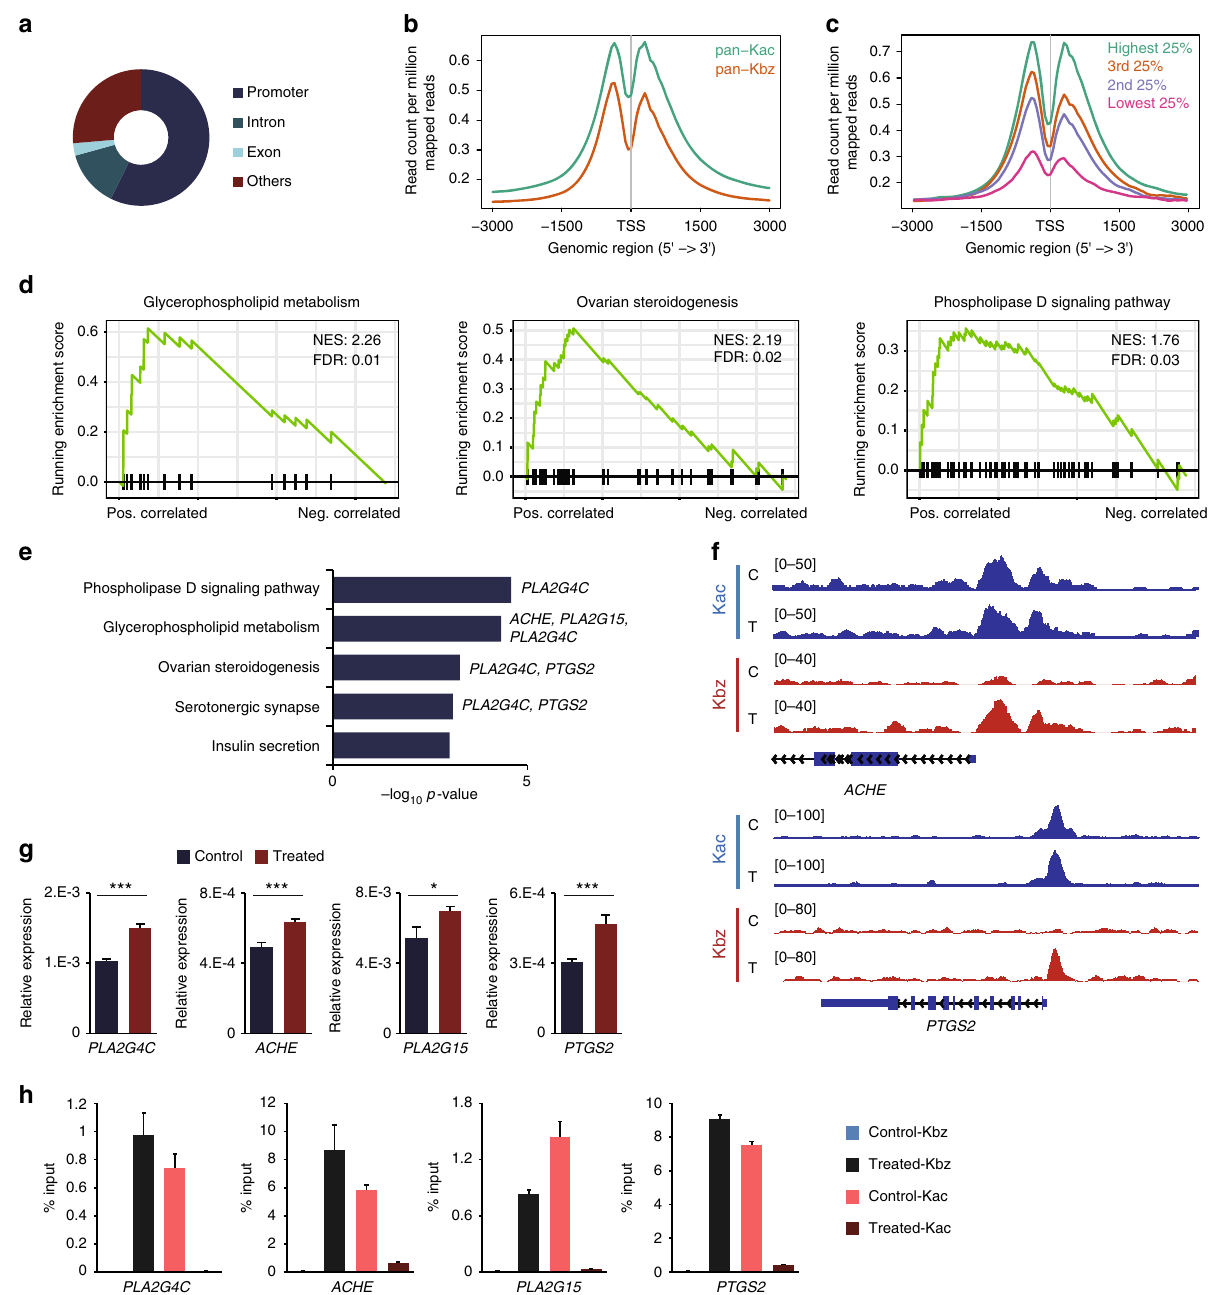
Fig. 6 Genome-wide localization and physiological relevance of histone K bz in HepG2 cells. a Genome-wide distribution of histone K bz in SB-treated HepG2 cells. b Curves showing average pro fi le of histone K bz and K ac ChIP-seq read counts (per million mapped) around all known TSSs. c All genes were split into four equal groups based on their expression levels calculated from RNA-seq data. The average pro fi les of histone K bz ChIP-seq read counts (per million mapped) for each group were plotted at all known TSSs. d KEGG pathway analysis of RNA-seq data using GSEA. e KEGG pathway analysis of selected genes. The genes selected for validation in each pathway were labeled. f A representative snapshot showing the normalized ChIP-seq reads for K bz and K ac at ACHE and PTGS2 genes (C: control, T: SB-treated). g RT-qPCR analysis of the control and SB-treated HepG2 cells. Relative expression is normalized to